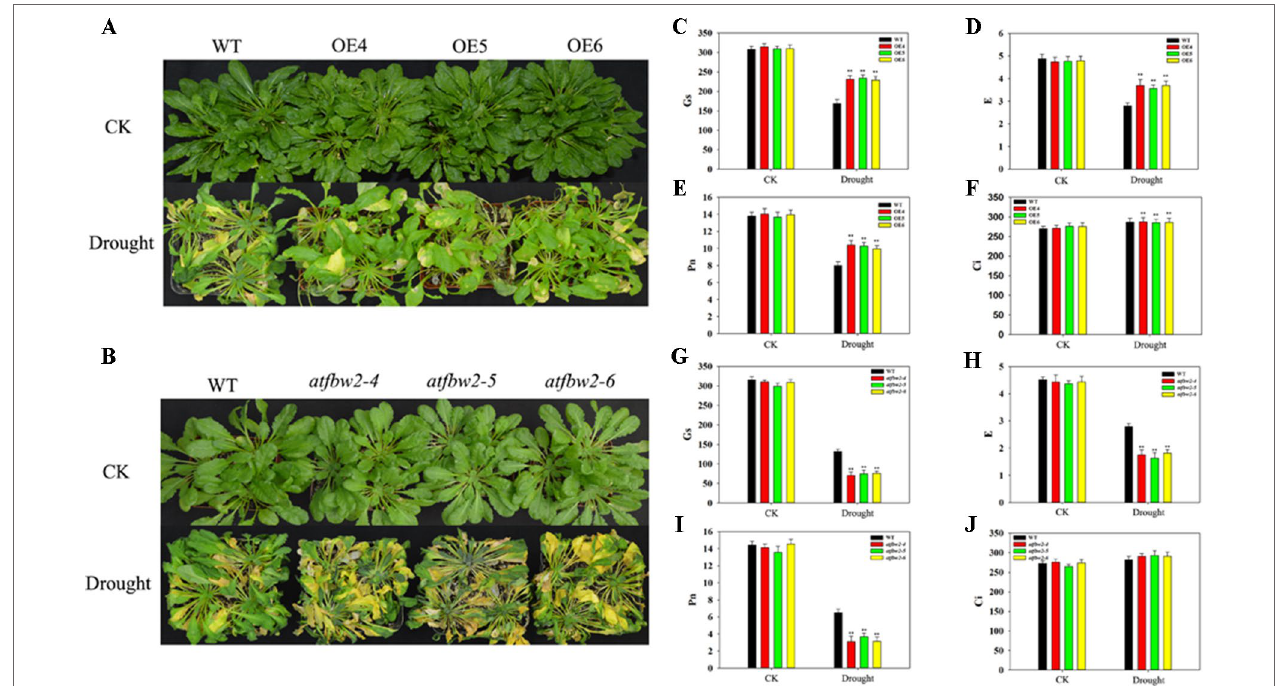
FIGURE 4 | Growth and photosynthetic capacity of Arabidopsis plants under drought stress. (A) Phenotypes of WT and TaFBA1-overexpressing lines (OE4, OE5, OE6), and (B) WT and mutant ( atfbw2-4 , atfbw2-5, atfbw2-6 ) lines. (C , G) Stomatal conductance (Gs), (D , H) transpiration rate (E) , (E , I) net photosynthetic rate (Pn), and (F , J) intercellular CO 2 concentration (Ci) of Arabidopsis leaves in TaFBA1 -overexpression (C – F) and mutants lines (G – J) under normal and drought stress treatments. Data represent the mean ± SE of three biological replicates. * P < 0.05; ** P <